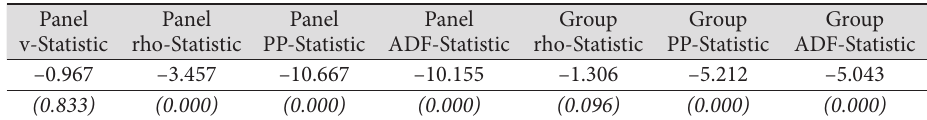
Table 11. Panel co-integration tests (operating expenses) Panel Panel Panel Panel Group Group Group v-Statistic rho-Statistic PP-Statistic ADF-Statistic rho-Statistic PP-Statistic ADF-Statistic log( GDP ) 0.733 0.080 0.020 0.557 0.058 0.008 0.540 log( REX ) 0.958 0.882 0.520 0.336 0.944 0.665 0.144 HICP 0.079 STI 0.001 0.010 log( CPE ) 0.065 0.000 0.000 0.073 0.000 0.000 0.006 UNR 0.553 0.514 0.227 0.602 0.428 0.132 0.483 log( A ) 0.000 0.000 CL 0.903 0.943 0.929 0.980 0.986 0.981 0.983 log( PRO ) 0.379 0.321 0.049 0.290 0.591 0.121 0.531 HHI